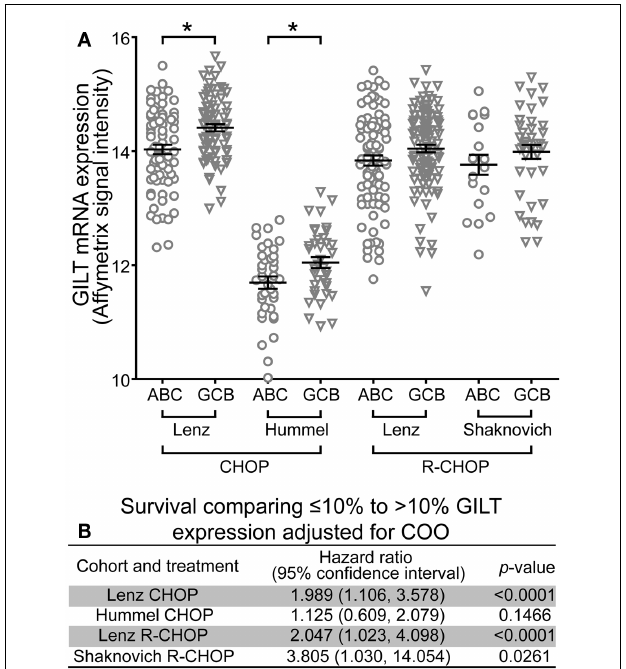
FIGURE 3 |Association of GILT expression with survival is independent of COO classification . (A) The relative mRNA expression of GILT in patients classified as GCB or ABC subtype in the four cohorts. Each symbol represents an individual patient. Comparison of GILT expression in GCB and ABC subtypes using a two sample independent t -test revealed p = 0.0003 in the Lenz CHOP, p = 0.0179 in the Hummel CHOP, p = 0.0653 in the Lenz R-CHOP, and p = 0.2887 in the Shaknovich R-CHOP cohort.The line and error bars indicate the mean ± SEM (* p < 0.05). (B) Adjusted for COO subtype, the hazard ratio, 95% confidence interval and p -value comparing survival of patients with ≤ 10 to > 10% expression of GILT in each